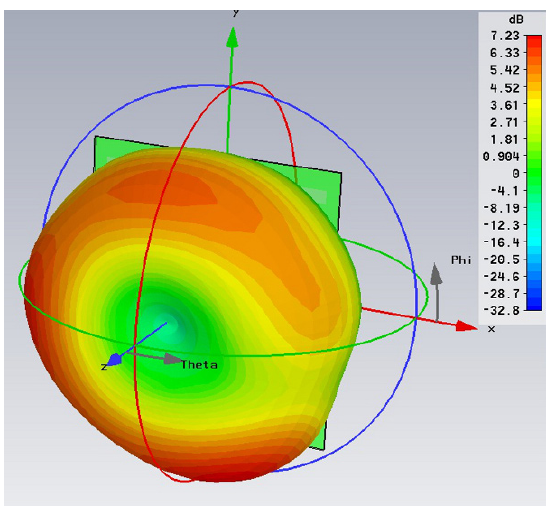
Figure 11. Radiation pattern for 45°.